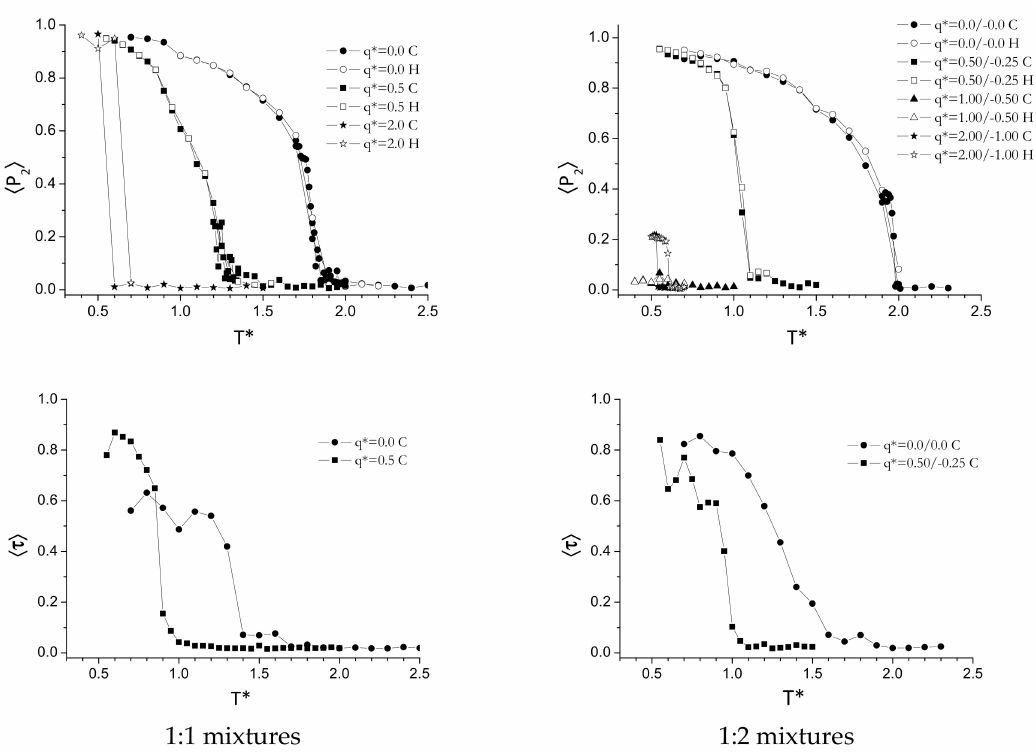
Figure 4. Dependence of the orientational order parameter, (cid:104) P 2 (cid:105) , (top panels) and translational order parameter, (cid:104) τ (cid:105) , (bottom panels) on the scaled temperature, T *. The left panels refer to the 1:1 stoichiometry; the right panels to the 1:2 stoichiometry. Packing fraction η * = 0.428. H and C refer to heating and cooling runs, respectively